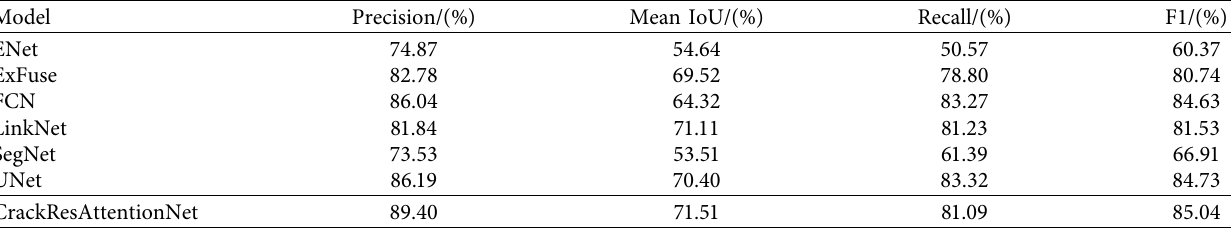
Table 4: Public Crack Dataset- BCE loss.